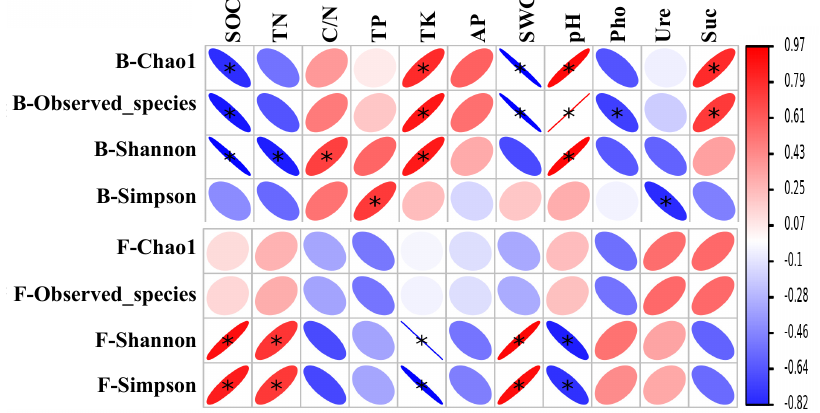
Soil physicochemical properties and enzyme activities were more closely related to